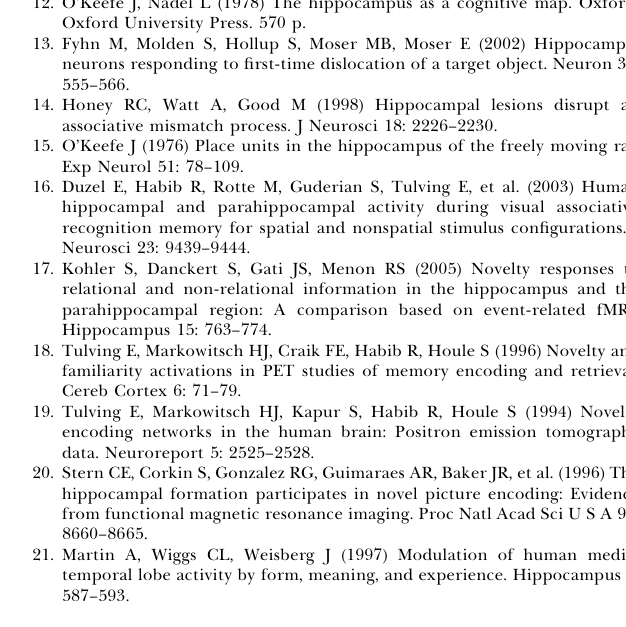
Figure S1. Brain Areas Significantly More Active during First Presentation as Compared to Baseline Condition: FIRST . BASE Significantly greater activation observed in this comparison (FIRST . BASE) in a distributed network of brain regions, including left hippocampus ( x, y, z ¼ 24, (cid:2) 24, (cid:2) 15; z ¼ 3.79), right entorhinal/ perirhinal cortex ( x, y, z ¼ 21, - (cid:2) 12, (cid:2) 27; z ¼ 4.96), left medial